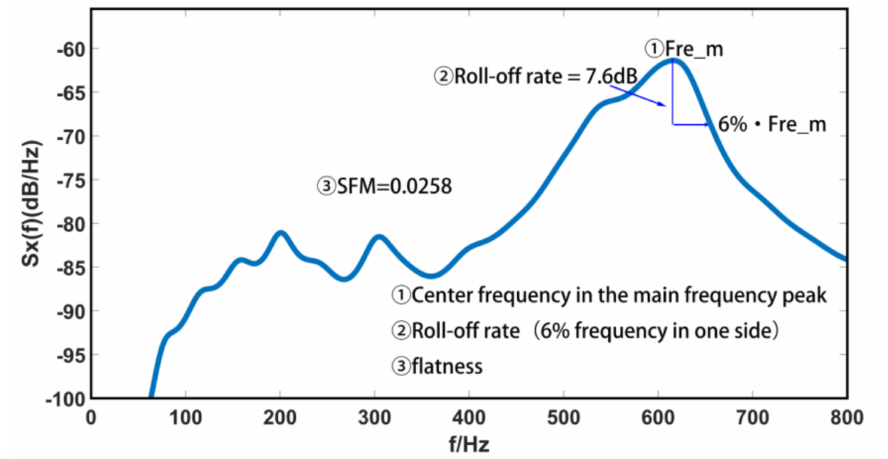
Figure 4. Application of the frequency characteristic parameters in a specific